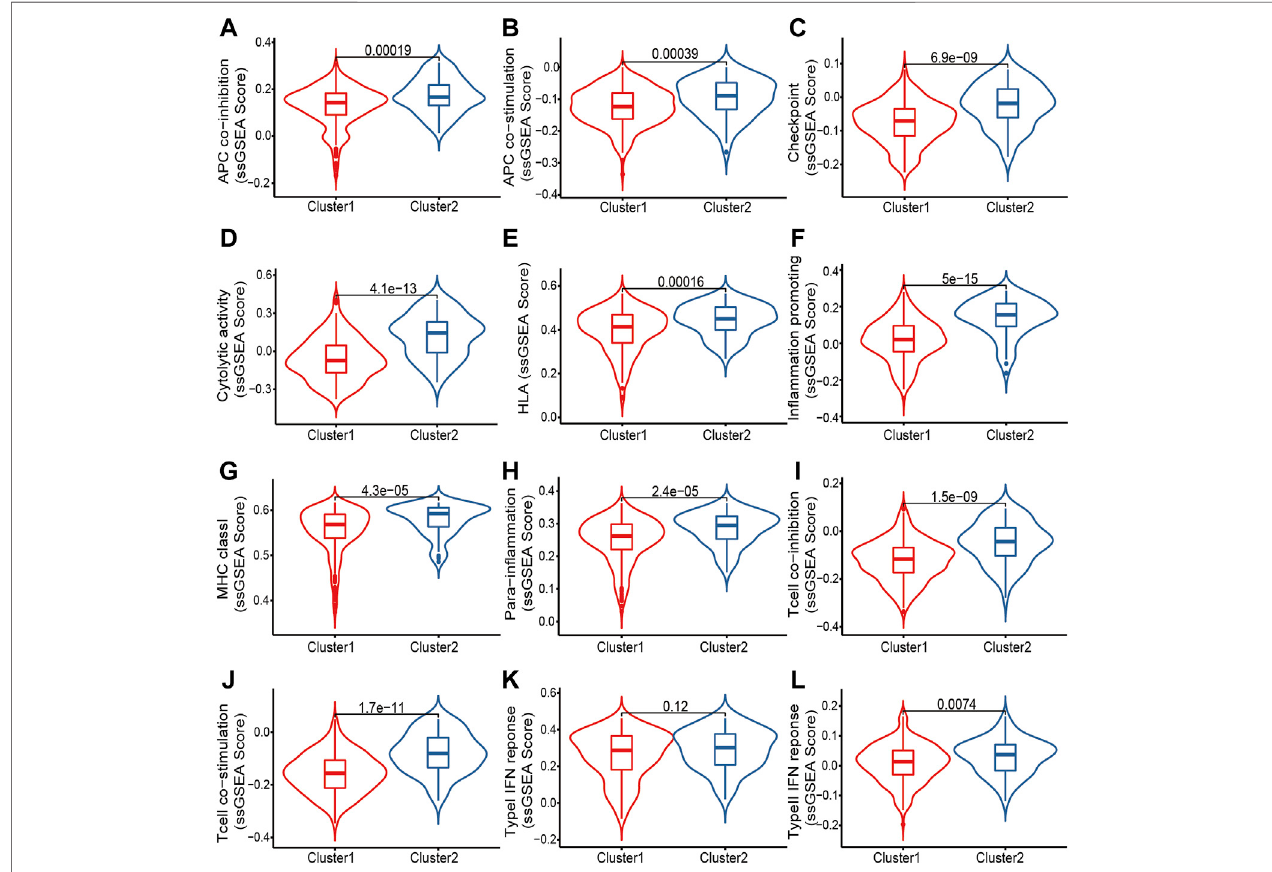
FIGURE4| Comparisons ofssGSEA scoresof12immunotherapy-related genesets intwoclustersofOCpatients. (A) APC co-inhibition; (B) APC co-stimulation; (C) Checkpoint; (D) Cytolytic activity; (E) HLA; (F) In fl ammation promoting; (G) MHC class I; (H) Para-in fl ammation; (I) T cell co-inhibition; (J) T cell co-stimulation; (K) Type I IFN response; (L) Type II IFN